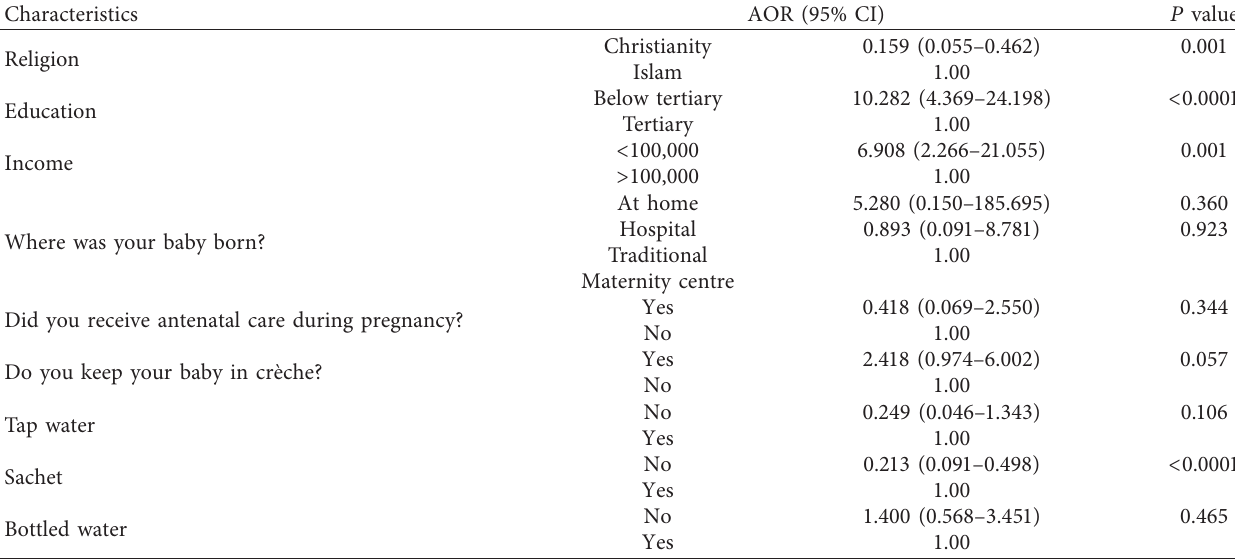
Table 6: Summary of Multivariate analysis of selected